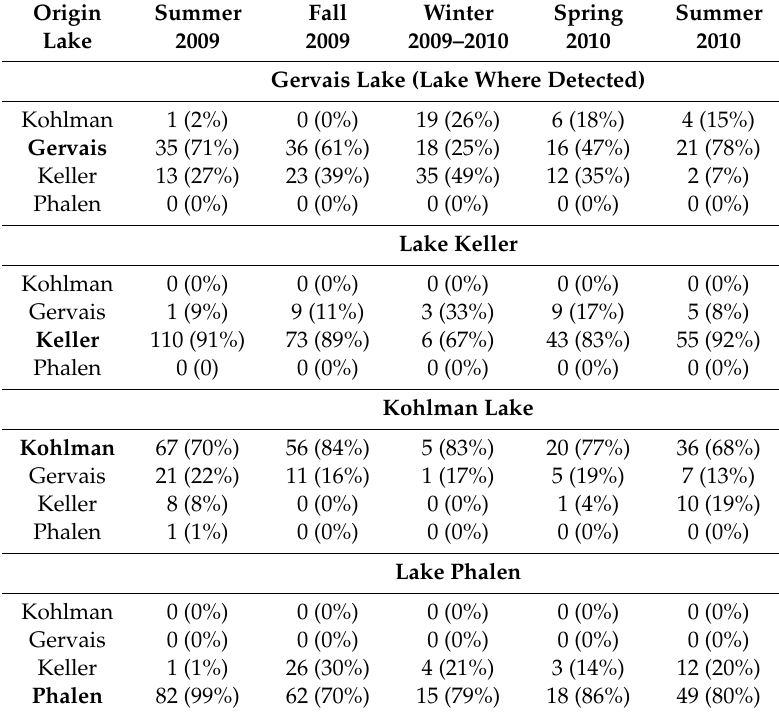
Table 2. The absolute number and percentage of total detections of 50 adult carp originally radio-tagged in lakes Gervais, Keller, Kohlman, and Phalen found in 2009 by lake and by season. Emboldened lake names in the left column denote the lake where the carp were originally